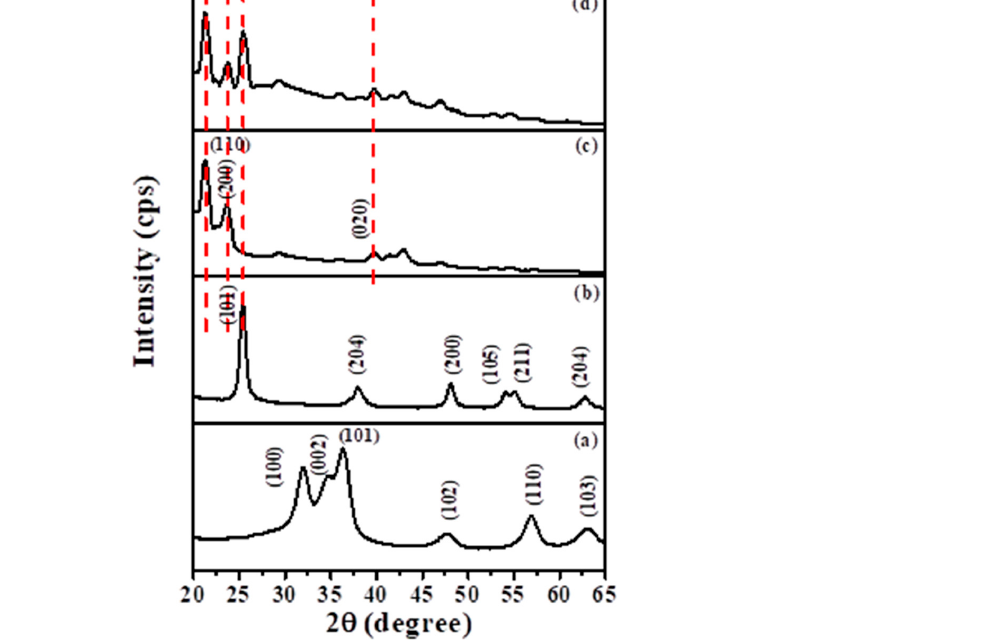
Figure 3. TEM image of ( a ) ZT and ( b ) ZnO QDs. The average particle size is shown in the insert.